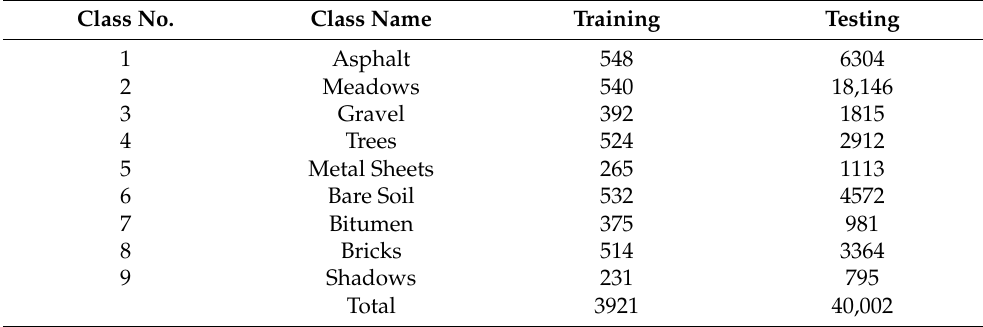
Table 4. Land-cover classes with corresponding standard training and testing pixels on Pavia University